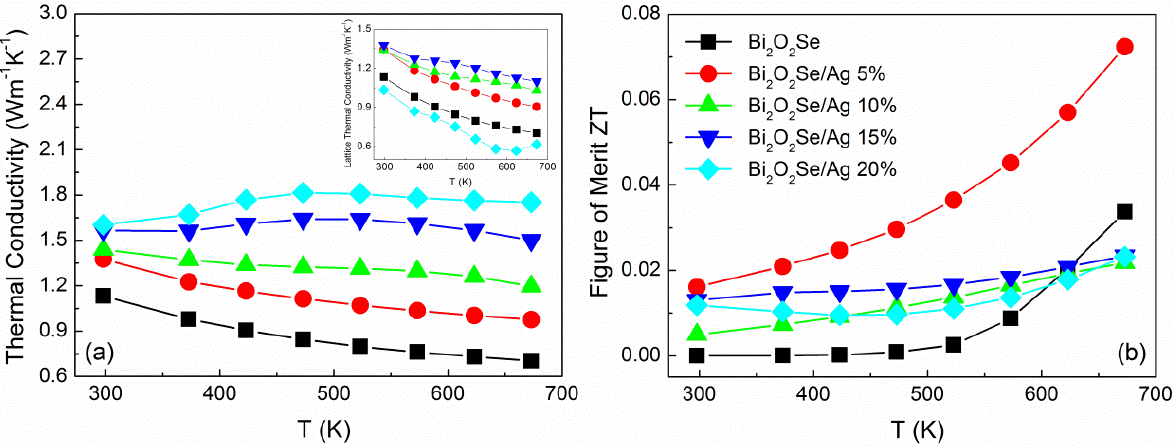
Figure 4. Temperature dependence of ( a ) thermal conductivity; and ( b ) ZT value for Bi 2 O 2 Se/Ag